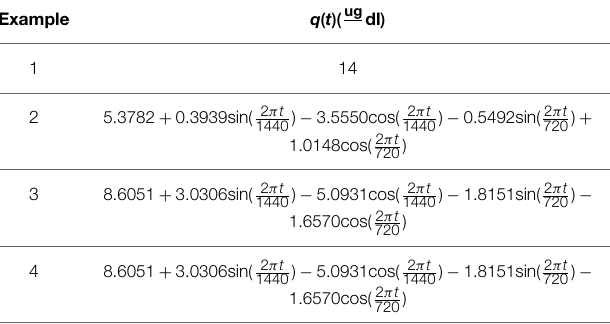
TABLE 2 | Upper bounds for examples of optimization problem (Equation 1). Example